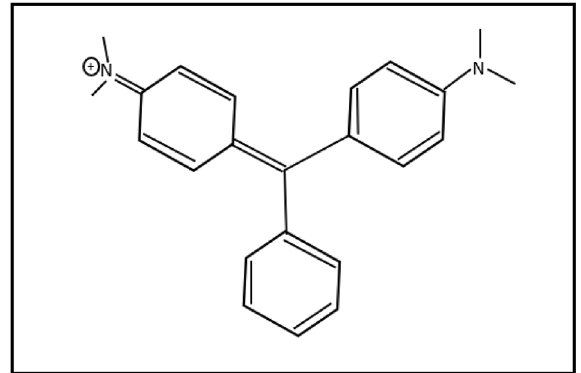
Figure 1. Malachite green (MG) dye chemical